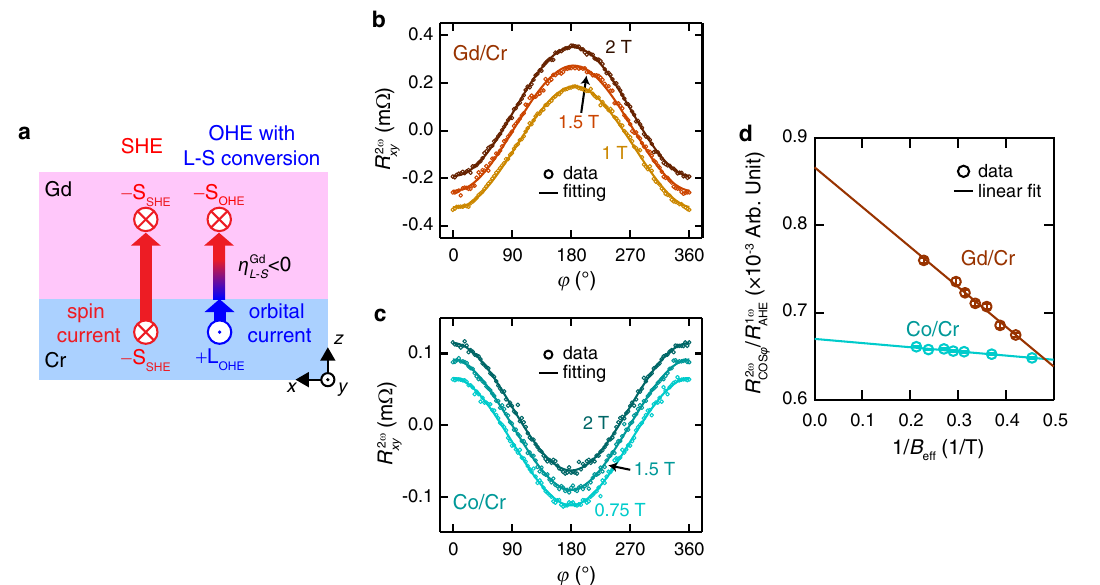
Fig. 2 Ef fi cient orbital-to-spin conversion by rare-earth Gd with strong spin – orbit coupling. a Schematic illustration of the orbital-to-spin ( L – S ) conversion by η Gd L in the Cr/Gd heterostructure. The spin (orbital) angular momentum is represented by S ( L ). The source of S and L is marked by the (cid:2) S subscript of SHE (OHE) for spin Hall effect (orbital Hall effect). b , c R 2 ω xy ð φ Þ under different B ext of Gd (10 nm)/Cr (5 nm) ( b ) and Co (10 nm)/Cr (5 nm) ( c ) samples. Each R 2 ω xy ð φ Þ of Gd/Cr ( b ) and Co/Cr ( c ) is shifted by a y -axis offset to clearly show B ext dependence. The solid lines are the fi tting curves using Eq. = R 1 ω (2). d R 2 ω versus 1/ B eff of Gd/Cr (brown) and Co/Cr (blue-green) samples. Each solid line is the linear fi tting line. All measurements are conducted COS φ AHE at 10 K. The error bars in d are due to the standard deviation of the fi tting of the R 2 ω xy ð φ Þ versus φ curves using Eq. (2), which are smaller than the symbol